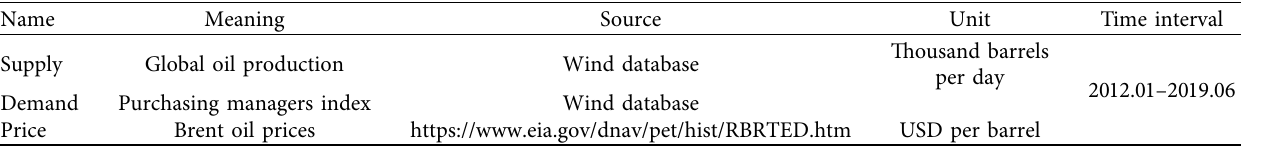
Table 2: Variable